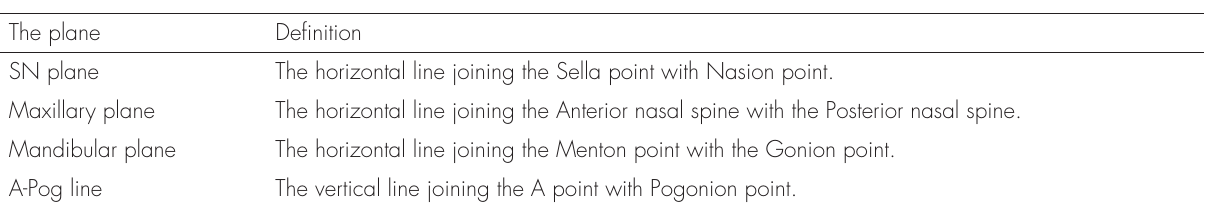
Table II. Cephalometric landmarks. The point Definition Sella The center of the pituitary fossa of sphenoid bone. Nasion The most anterior point of the frontonasal suture. Anterior nasal spine The tip of the median anterior bony process of the maxilla. Posterior nasal spine The tip of the posterior nasal spine. A point Prosthion. Incision superius The tip of the crown of the most prominent upper incisor. Apicale superius Root apex of the most prominent upper incisor. The deepest point on the concavity at the anterior surface of the mandibular symphysis. Incision inferius The tip of the crown of the most prominent lower incisor. Apicale inferius Root apex of the most prominent lower incisor. Pogonion The most anterior point at the bony chin. Menton The most inferior point on the mandibular symphysis. Gonion The most inferior posterior point at the angle of the mandible. Articulare The intersection of the shadow of the undersurface of the basi-occiput with that of the posterior border of the neck of the mandible, with the teeth being in centric occlusion. Basion The most anterior point on the margin of the foramen magnum. Table III. Reference The plane Definition